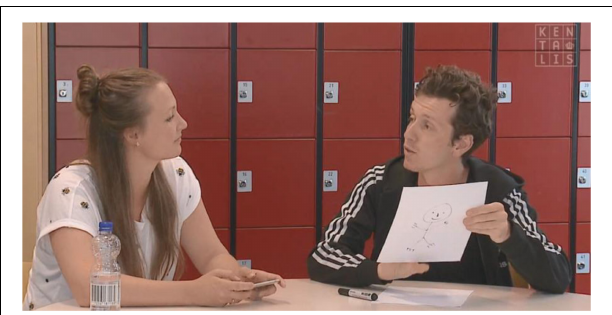
FIGURE 1 | Screenshot of the clip “white lie” in Dutch Spoken Language.